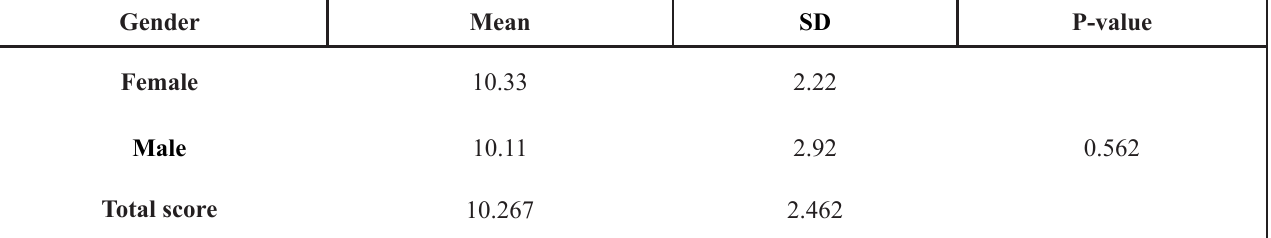
Table 2. Scores of knowledge of medical staff about the principles of radiation protection in terms of gender